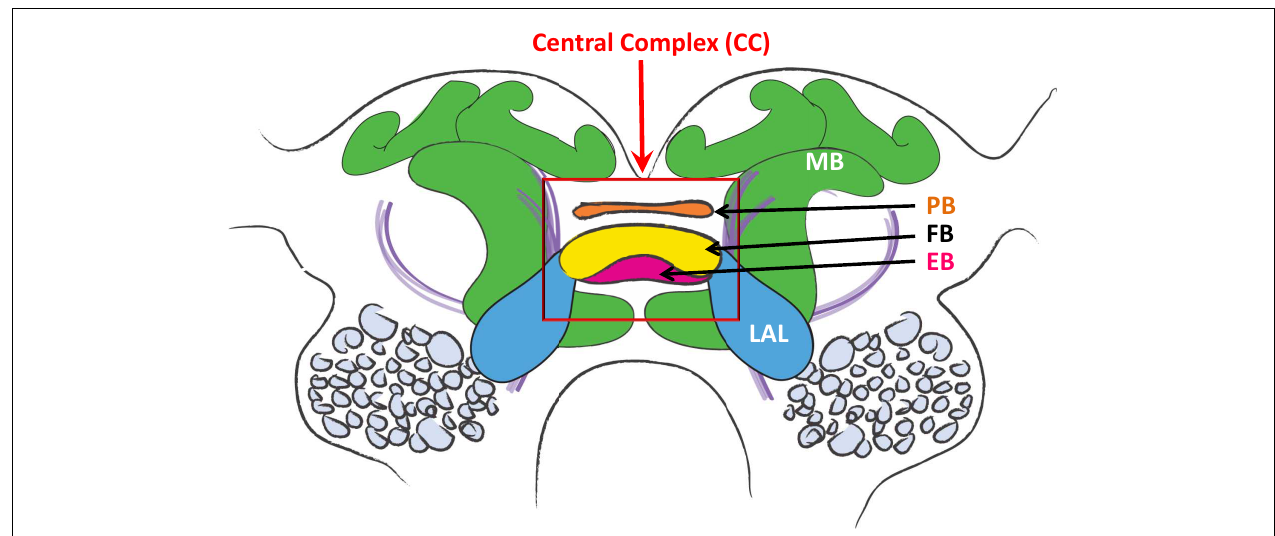
FIGURE 3 | Diagram of the cockroach brain. Central Complex is within red rectangle. PB, protocerebral bridge; FB, fan-shaped body; EB, ellipsoid body; LAL, lateral accessory lobes; MB, mushroom body.